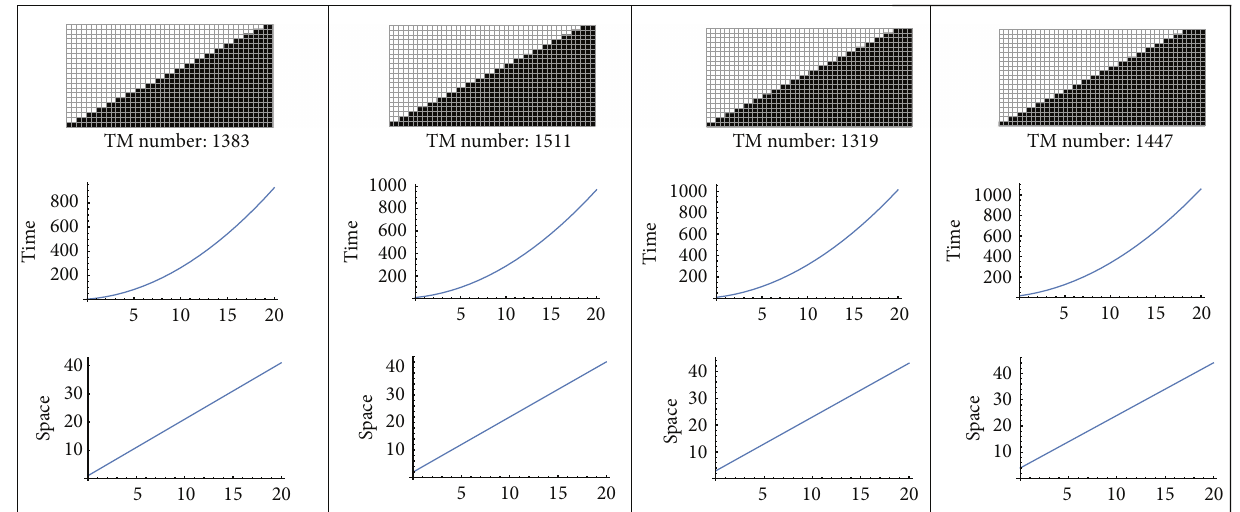
Figure 5: The figure shows the four different functions that are computed by the four TMs that have quadratic runtime in 2,2 space. The diagrams show the outputs on increasing inputs. So, for example, in the leftmost diagram, we see that TM with number 1383 (recall this is the code in (2,2) space) outputs two black consecutive cells on input 1, and more in general it outputs 2𝑛 black consecutive cells on input 𝑛